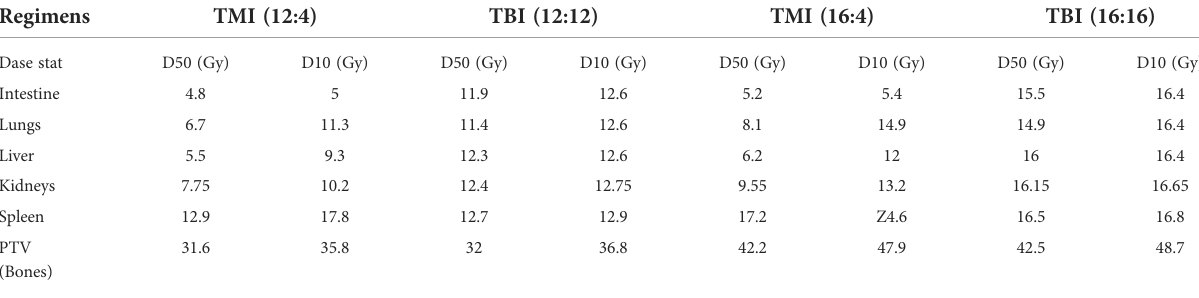
TABLE 1 Dose Distribution for different radiation